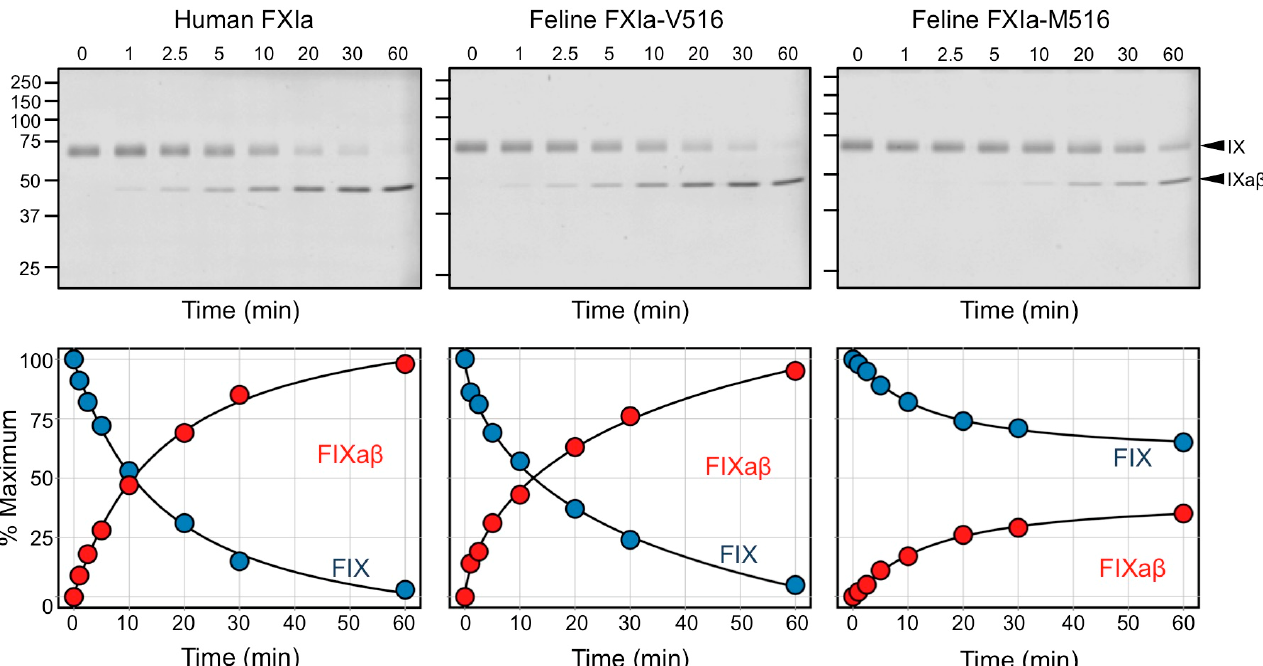
Figure 7. Factor IX Activation by FXIa . Time courses of 200 nM human FIX incubated with 2 nM human wild-type FXIa (hFXIa), feline wild-type FXIa (fFXIa-V516), and feline variant FXIa (fFXIa- M516). At the indicated times, samples were removed into non-reducing SDS-sample buffer. Samples were size fractionated on reducing 10% polyacrylamide gels and stained with Coomassie blue. Positions of standards for zymogen FIX (IX) and the protease FIXa β (IXa β ) are indicated on the right. Below each gel are results of densitometric analyses, showing reduction in FIX and formation of FIXa β as functions of time.